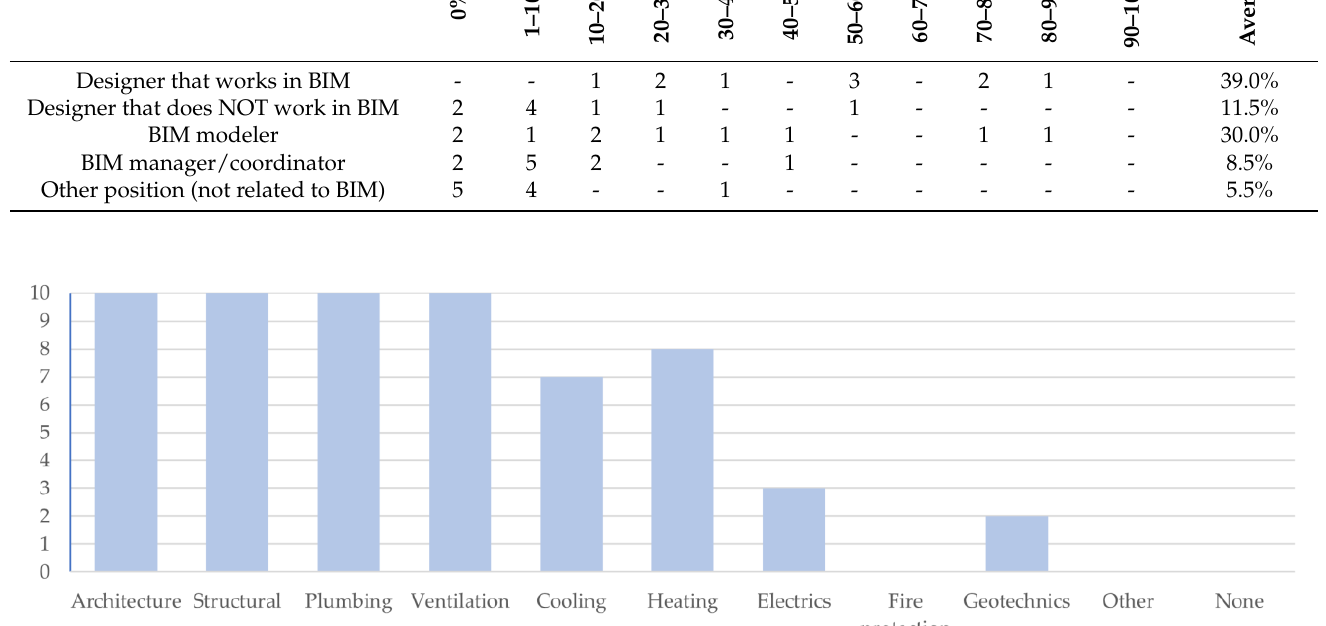
Figure 4. Responses to the question: “What disciplines were calculated and/or modeled in BIM by an engineer ?”.